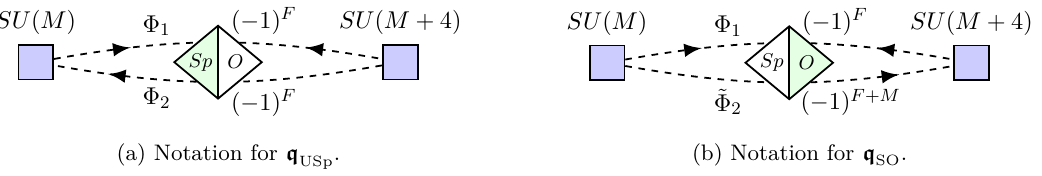
Figure 11. Abstract quiver notation for q and q . The dashed lines indicate the mesons USp SO Φ 1 and Φ 2 ( q ) or ˜Φ 2 ( q ), and the attached labels are their associated parities. The shaded USp SO half of the diamond distinguishes between q and q USp SO